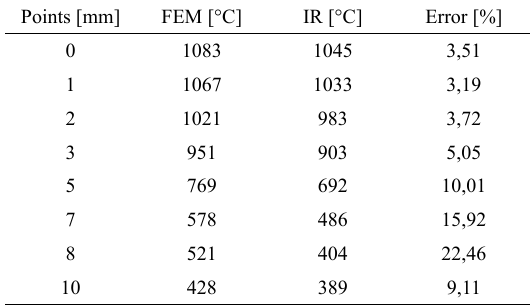
Table 5. Comparison between peak temperatures, according to the distance of the points with respect to the weld melt